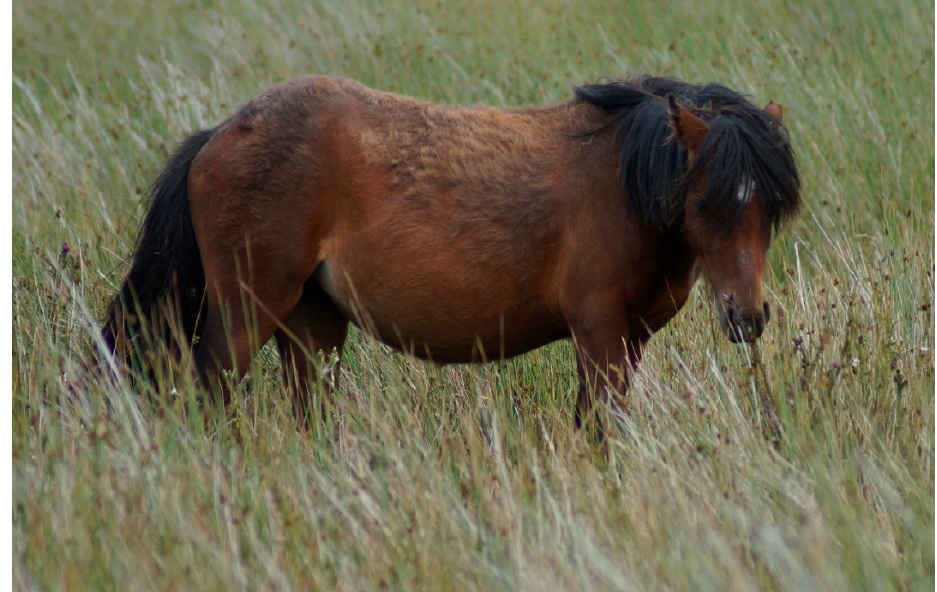
Figure 3. Coat/skin condition achieved very good reliability between observers. Picture is a sub- adult with poor coat quality taken August 2020. This particular band had to be monitored for an extended period of time due to significant time grazing in marshy area, with tall grasses that prohibited view of limbs for wounds/swelling, mobility, and hoof quality.